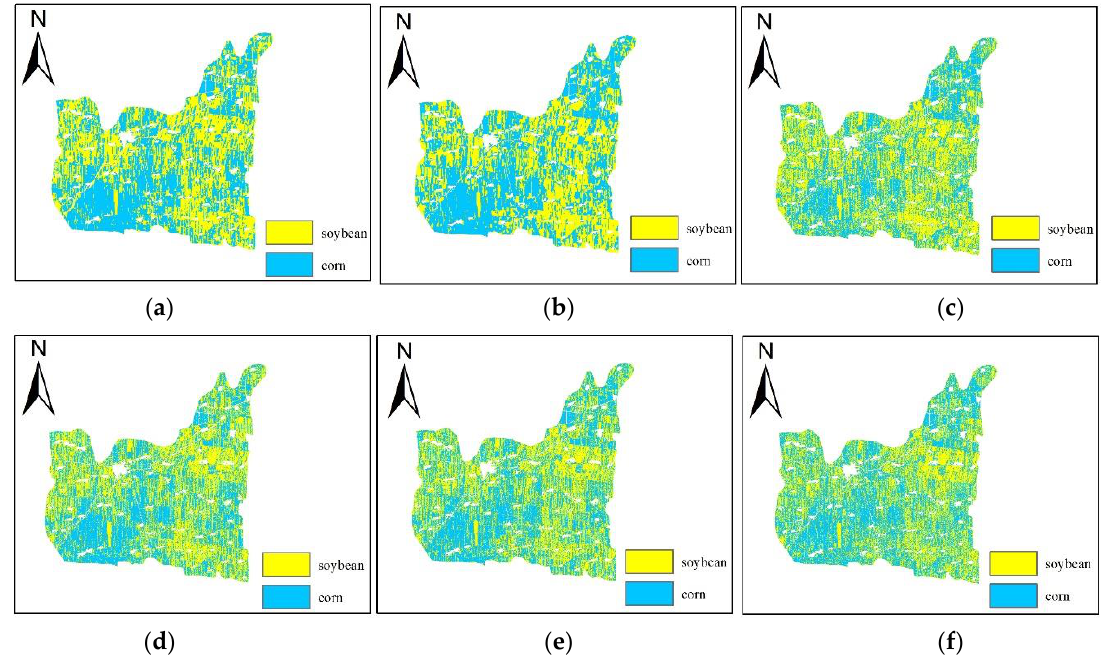
Figure 6. Crop classification results of highest crop classification accuracy with different time intervals in Tongnan town at 2018 (( a ), 10d_size15; ( b ), 15d_size20; ( c ), 30d_size5; ( d ), 10d_Pixel; ( e ), 15d_ Pixel; ( f ), 30d_ Pixel).